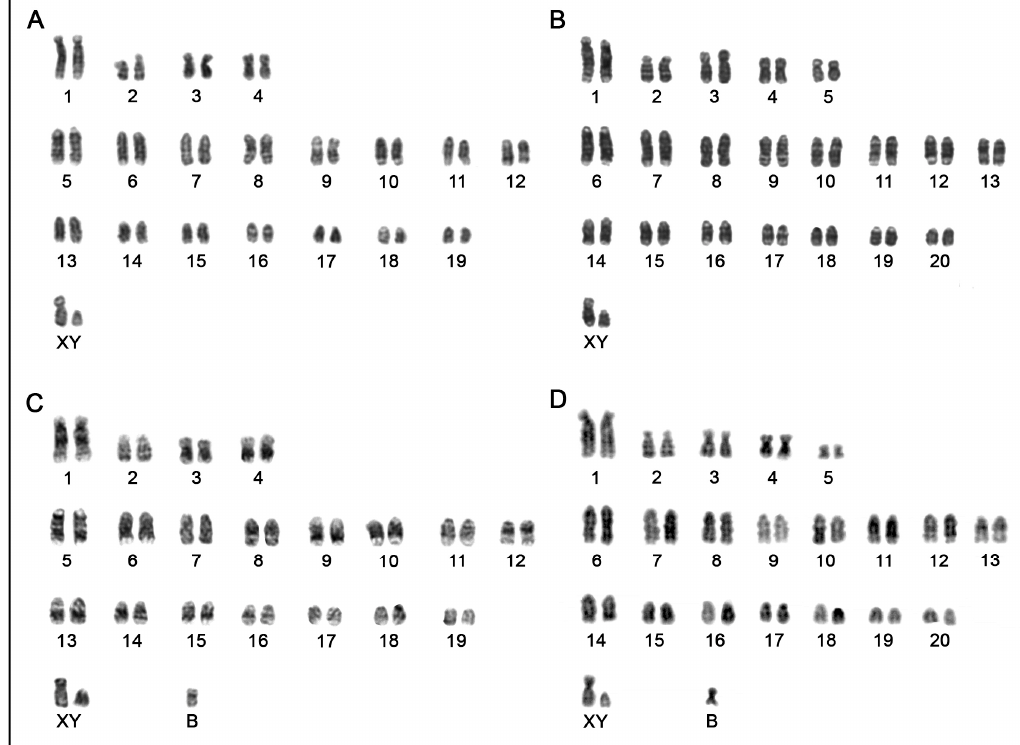
Figure 2. Examples of G-banded karyotypes of C. suaveolens found in the studied area. ( A ) Individual from the Guadalquivir River population (2n = 40). ( B ) Individual from the EDR population (2n = 42). ( C ) Individual from the Odiel River population (2n = 41). ( D ) Individual from the Tinto River population (2n = 43). Note the presence of a single B-chromosome in ( C ) and ( D ) karyotypes.